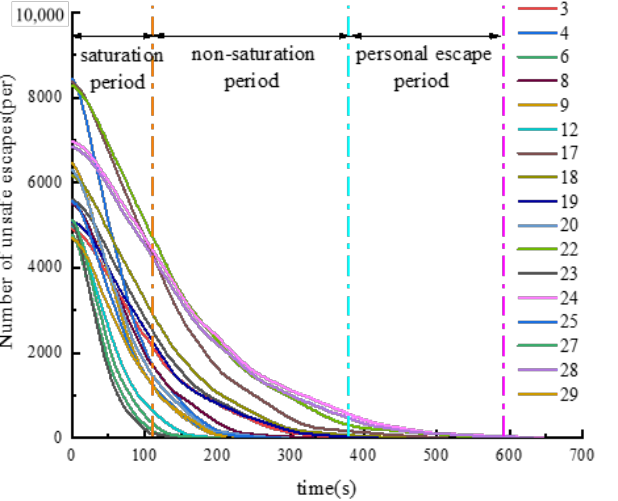
Figure 10. The curve of the number of pedestrians who failed to escape in group A with time.